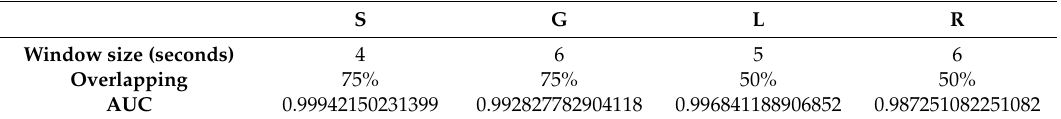
Table 12. The optimized parameters of ADM.